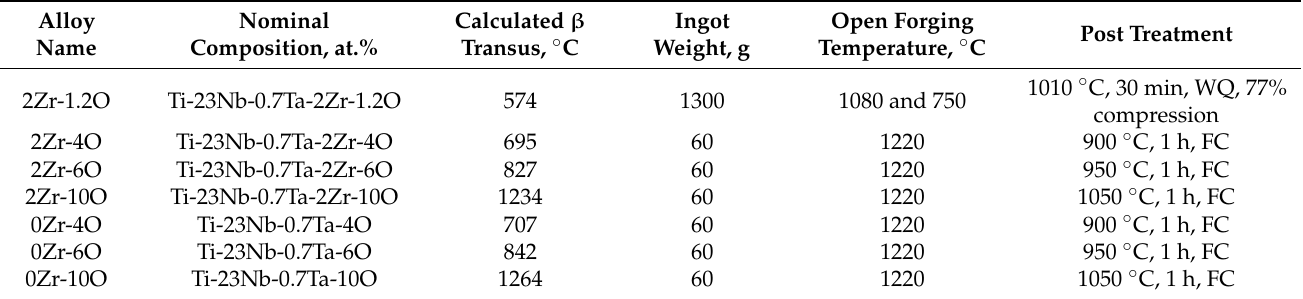
Table 1. Nominal compositions of the studied alloys and the heat treatments. WQ-water quenching, FC-furnace